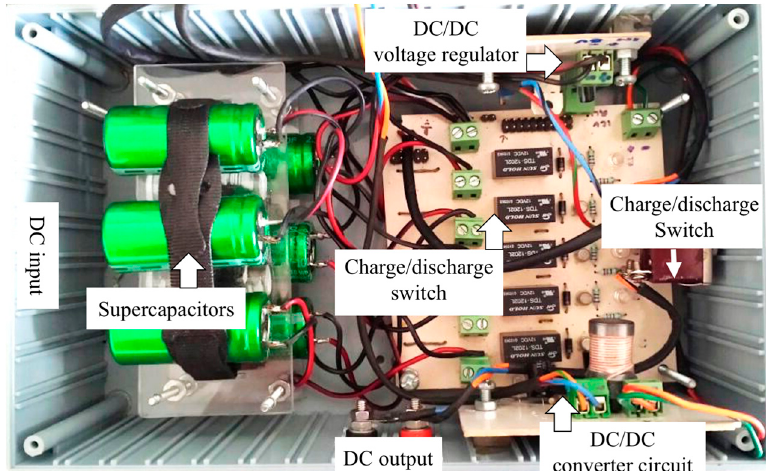
Figure 7. Electrical circuits of the storage bank.